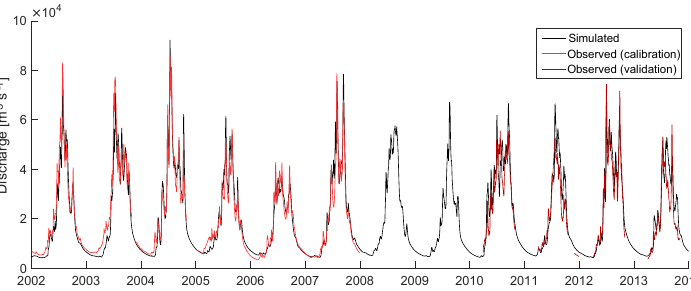
Figure 6. Observed vs. simulated discharge from the hydrologic–hydrodynamic model at Bahadurabad station. 2002–2007: calibration period. 2010–2013: validation period.